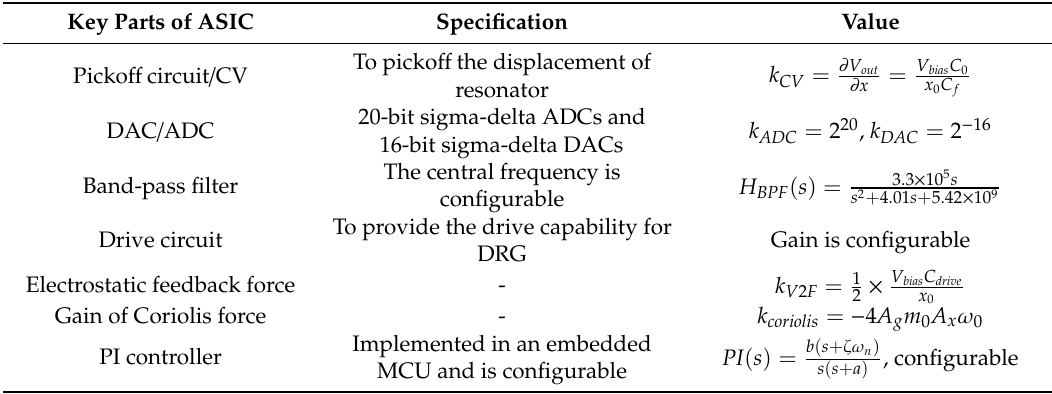
Table 2. Key parameters of disk resonator.